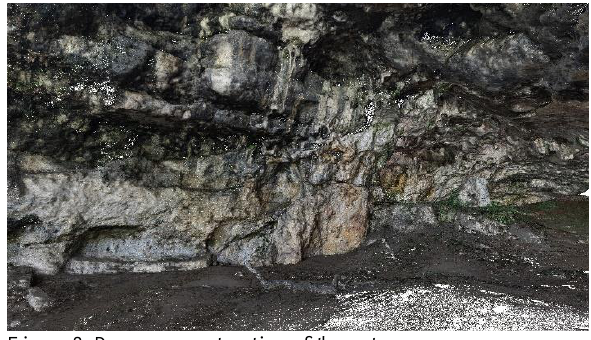
Figure 8. Dense reconstruction of the antrum